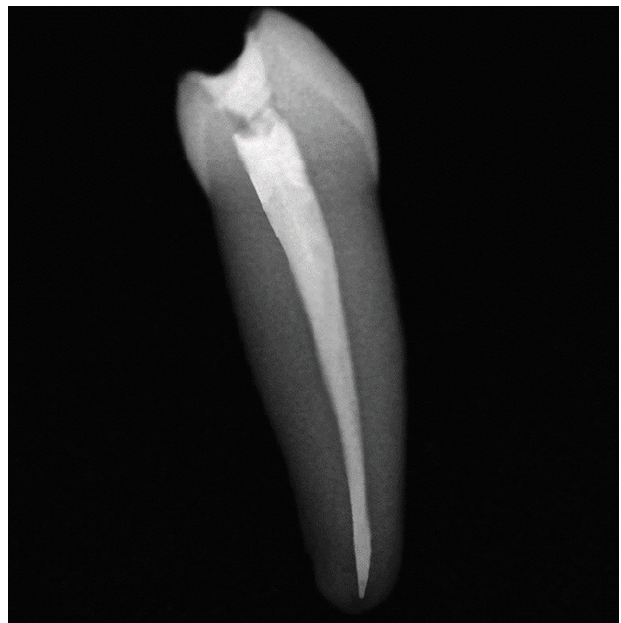
Figure 1. Post operative periapical radiograph showing the adequacy of the root fi lling.